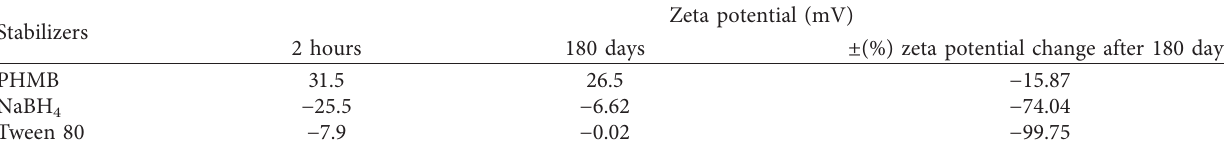
Table 1: Effect of stabilizers on zeta potential after 180 days.